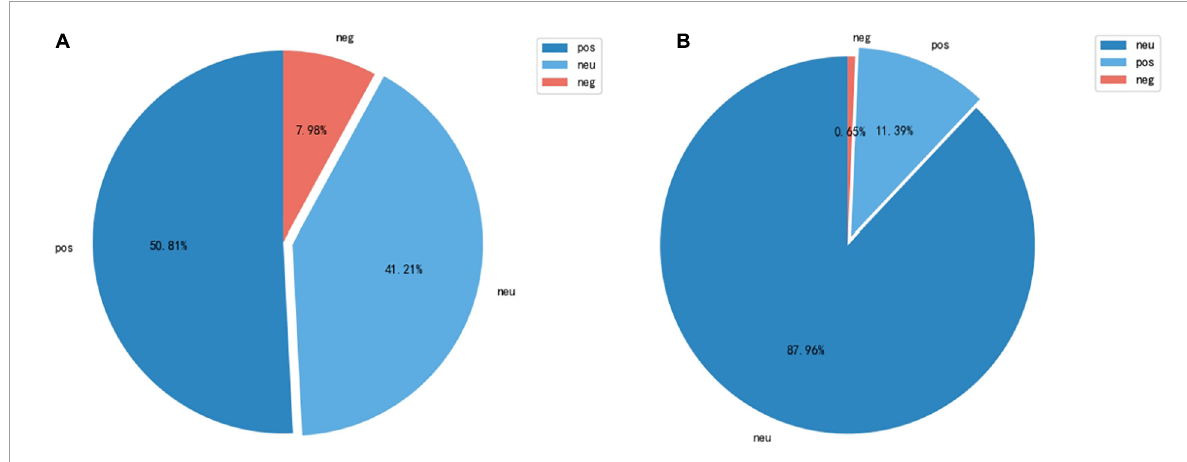
FIGURE7 Sentiment analysis. (A) Cluster 1 sentiment analysis. (B) Cluster 2 sentiment